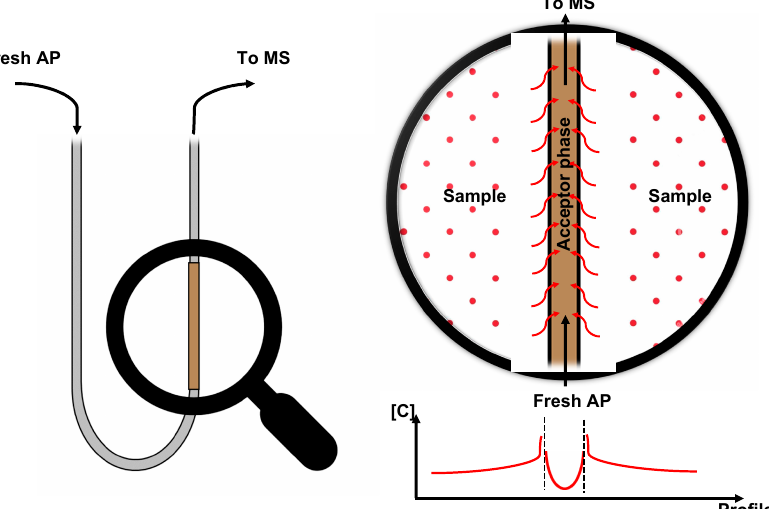
Figure 2. Example of CP-MIMS with concentration trend over the device profile .